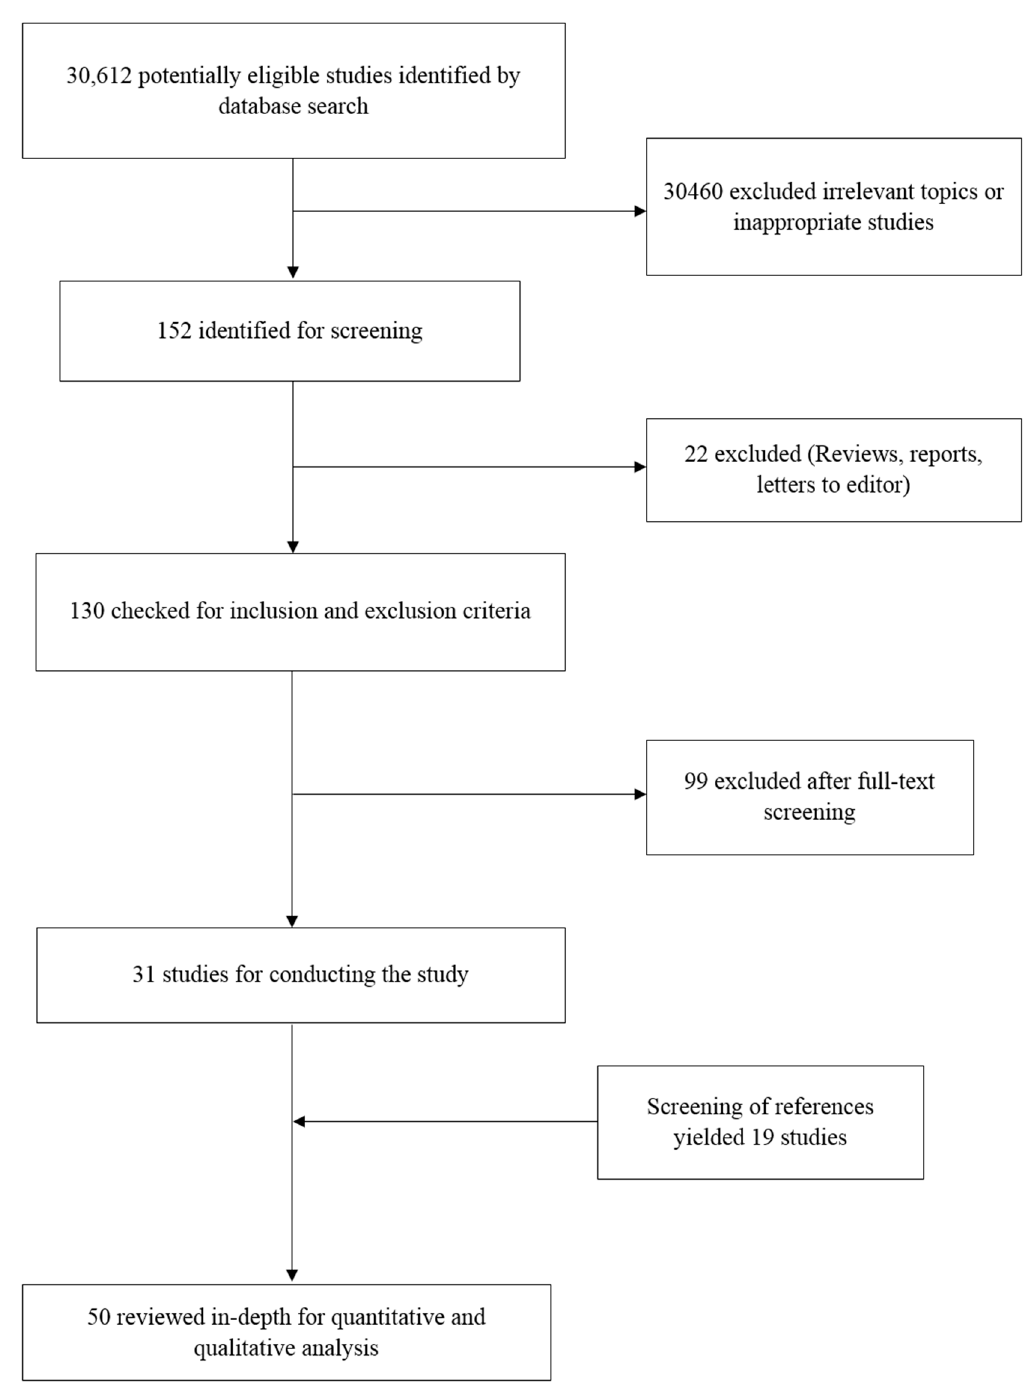
Figure 1. Flow chart describing search strategy.